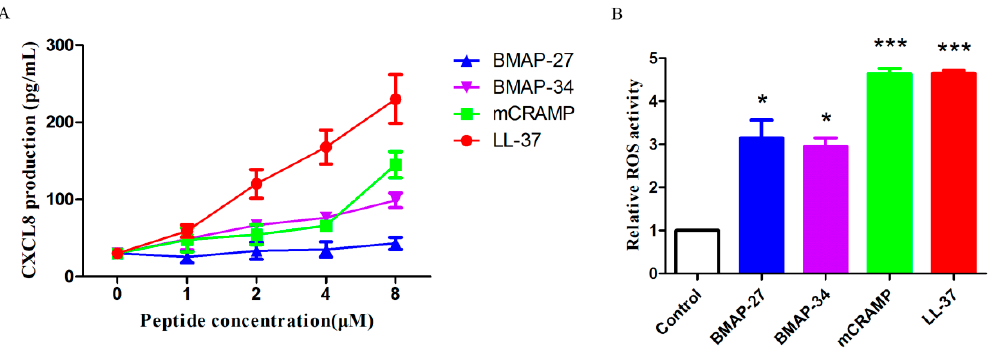
Figure 7. Mammalian cathelicidins affect the CXCL8 and ROS production. ( A ) CXCL8 production by human neutrophils in response to BMAP-27, BMAP-34, mCRAMP, and LL-37. ( B ) ROS production stimulated by the indicated concentrations of BMAP-27, BMAP-34, mCRAMP, and LL-37. Values represent the mean ± SD from three independent assays, * P < 0.05, *** P < 0.001.